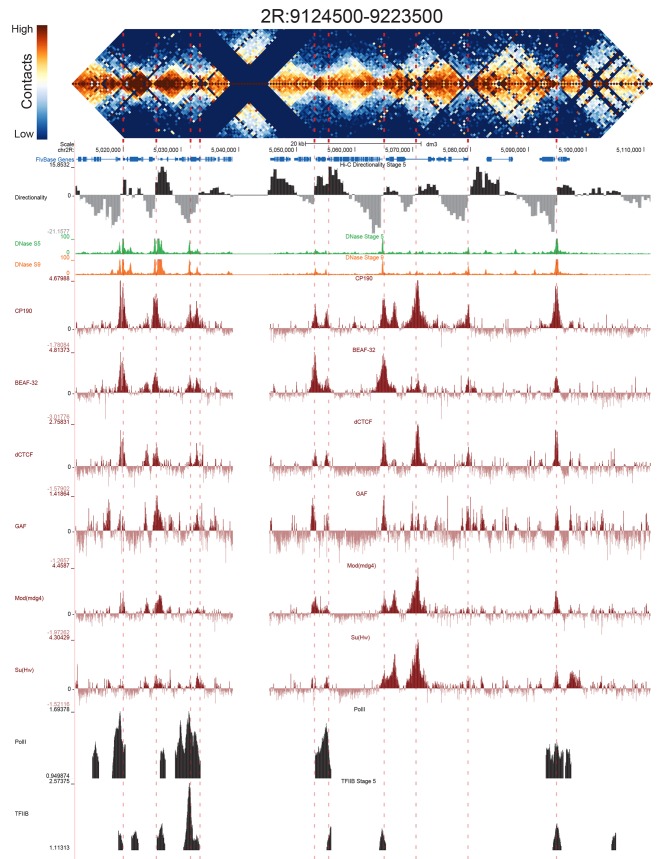
High resolution Hi-C maps of additional example genomic regions from stage 5 Drosophila melanogaster embryos.Region 2R:9124500–9223500 (dm3: 2R:5012000–5111000). Data were prepared identically to Figure 2, and all data is from the same sources.